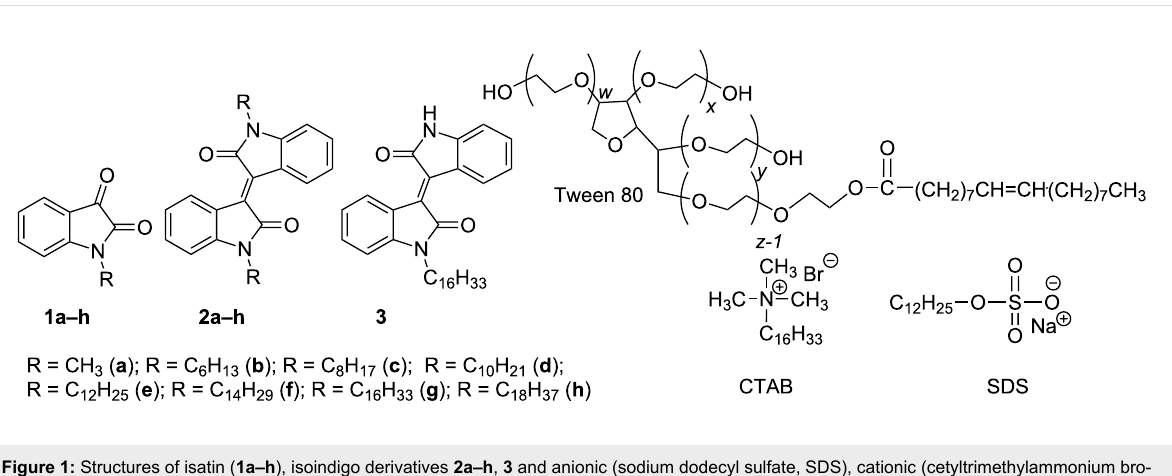
Figure 1: Structures of isatin ( 1a–h ), isoindigo derivatives 2a–h , 3 and anionic (sodium dodecyl sulfate, SDS), cationic (cetyltrimethylammonium bro- mide, CTAB) and nonionic (Tween 80)